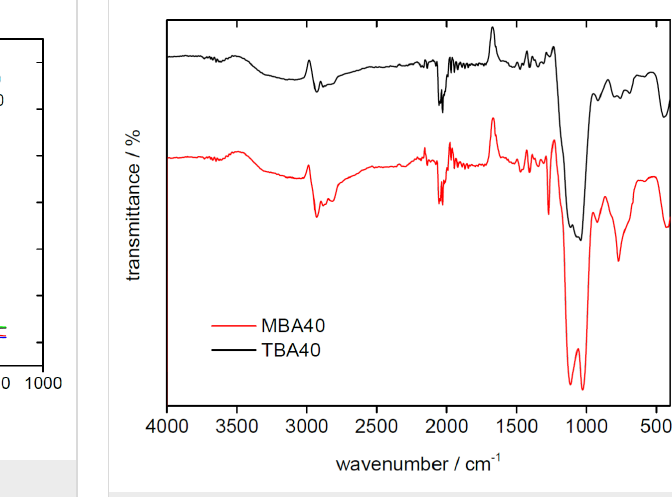
Figure 5: Representative IR spectra of TBA40 and MBA40.